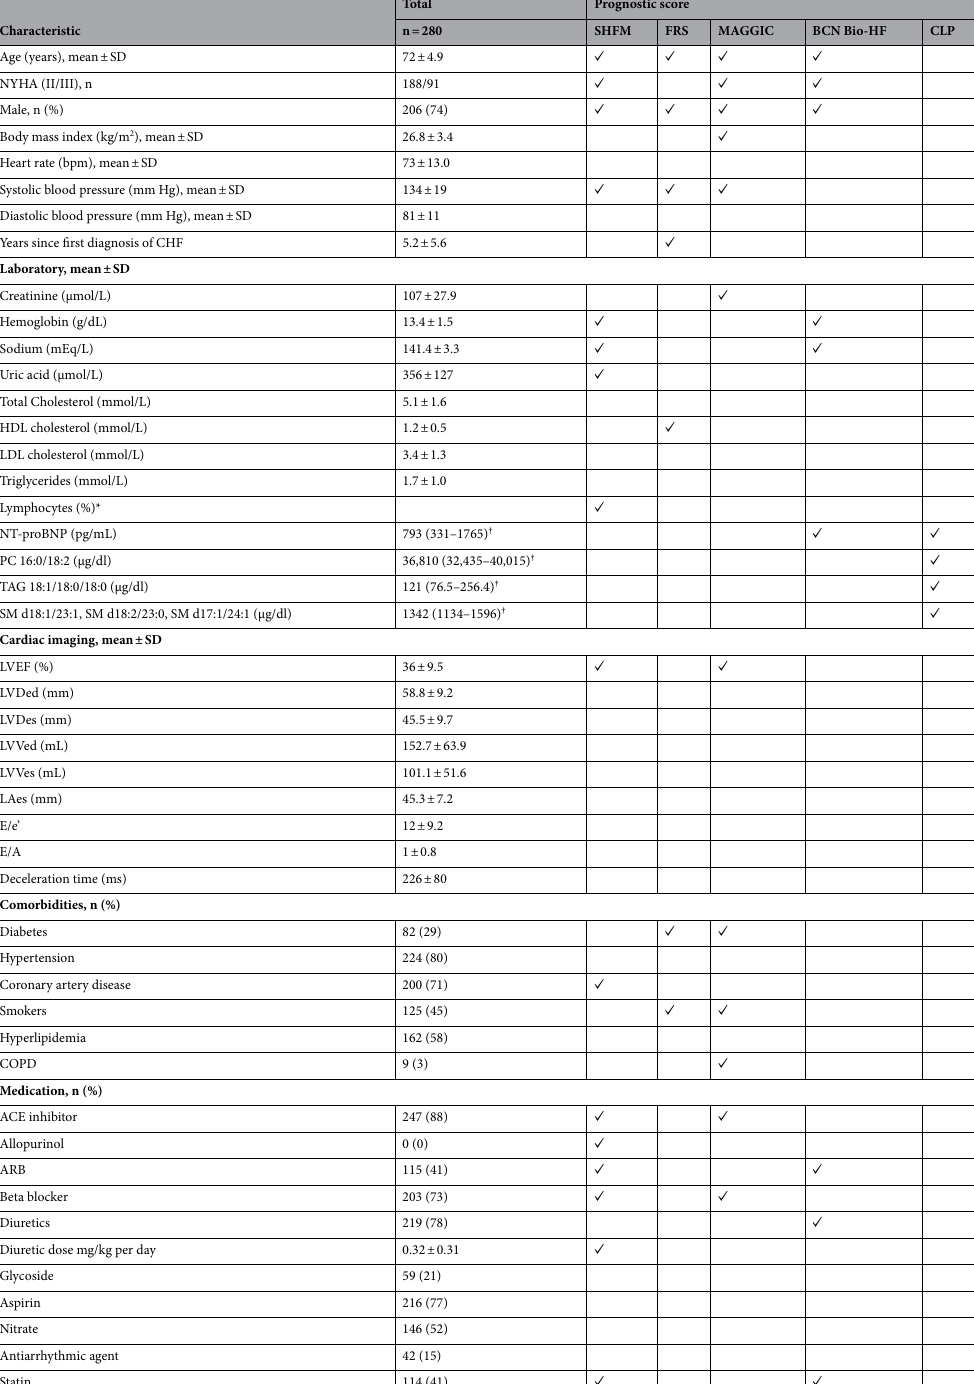
Table 1. Baseline characteristics of the study participants and variables included in each prognostic score. ACE, angiotensin-converting enzyme; ARB, angiotensin receptor blocker; BCN Bio-HF, Barcelona Bio-Heart Failure Risk Calculator; CLP, Cardiac Lipid Panel Risk Score; COPD, chronic obstructive pulmonary disease; E/A, ratio of the early (E) to late (A) ventricular filling velocities; E/e’, ratio between early mitral inflow velocity and mitral annular early diastolic velocity; FRS, Framingham Risk Score; LAes, left atrial end systole; LDL, low-density lipoprotein; NYHA, New York Heart Association; HDL, high-density lipoprotein; LVDed, left ventricular diameter end diastole; LVDes, left ventricular diameter end systole; LVVed, left ventricular volume end diastole; LVEF, left ventricular ejection fraction; LVVes, left ventricular volume end systole; mg/kg, milligrams per kilograms; MAGGIC, Meta-analysis Global Group in Chronic Heart Failure; NTpro-BNP, N-terminal pro–B- type natriuretic; PC, phosphatidylcholine; SHFM, Seattle Heart Failure Model; SM, sphingomyelin; TAG, triacylglycerol. * Imputed using the median, 31%, of the normal range 20–40%. † Median (Interquartile